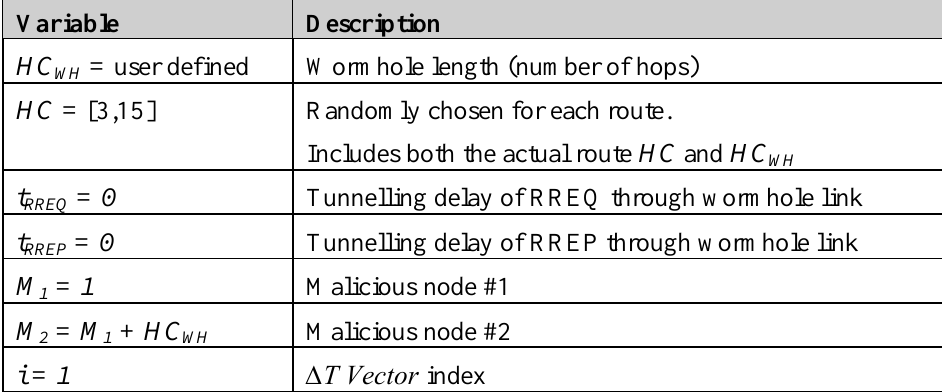
Table A1. Variables used in the simulation tool and their initial values.